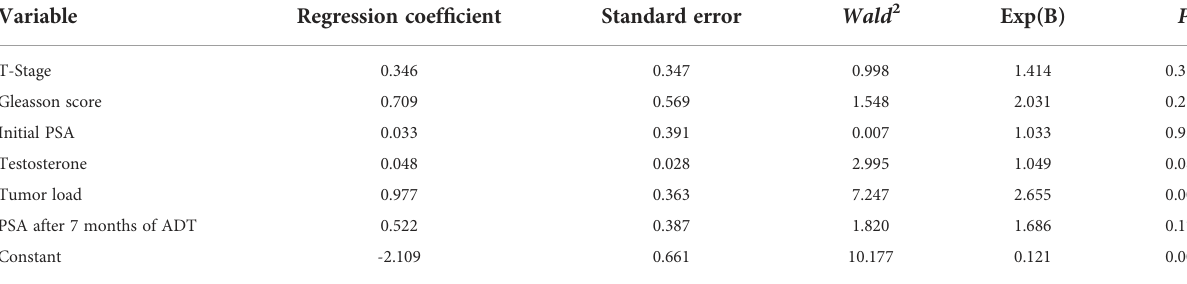
TABLE 3 Multifactorial Logistic Regression Analysis of mPCA Combined with MetS.